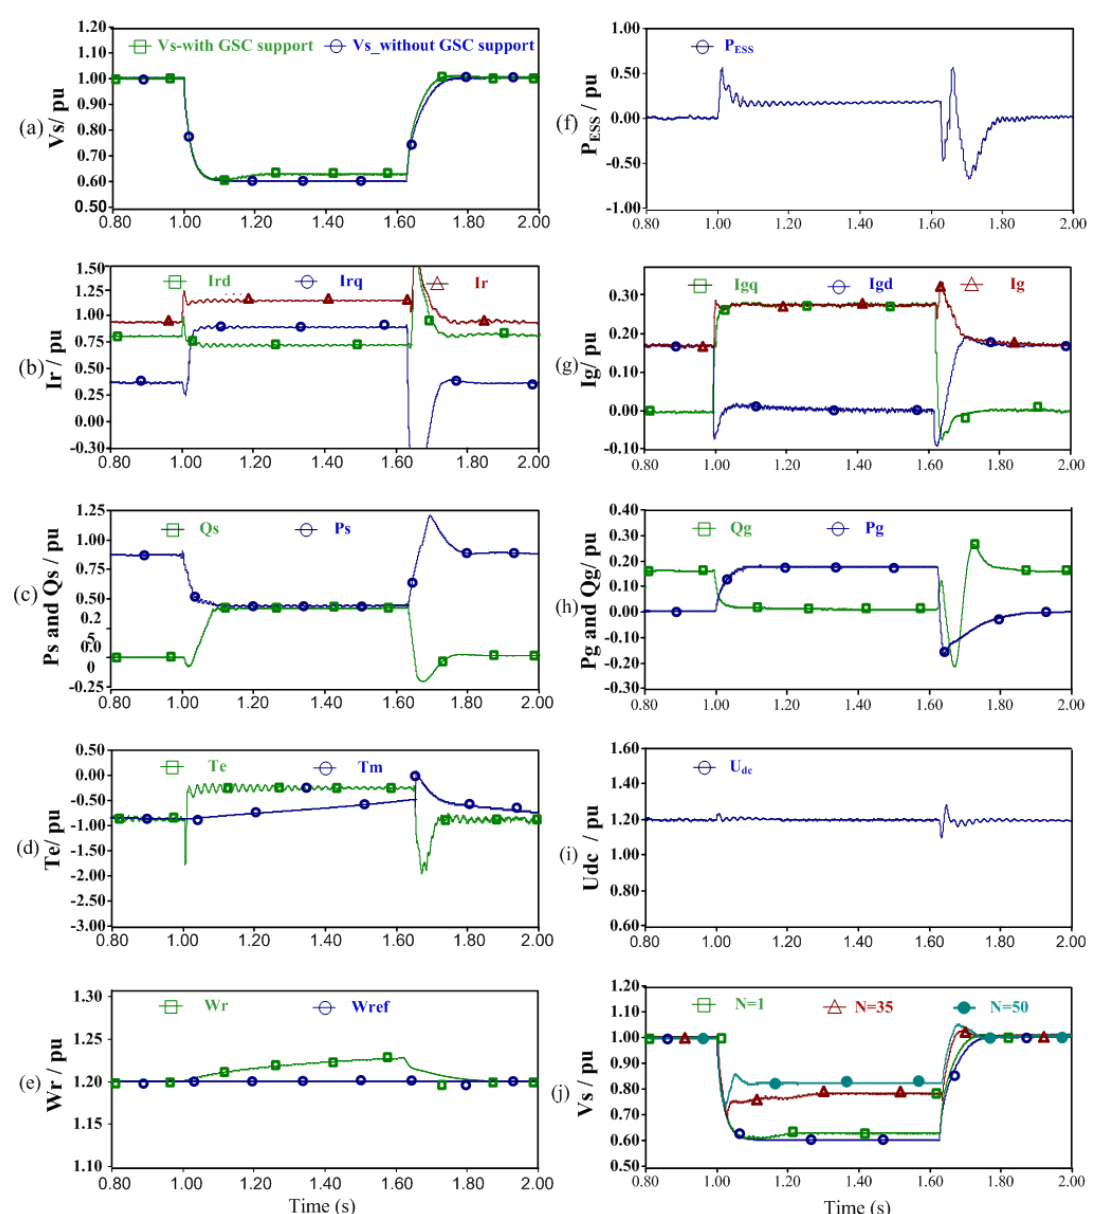
Figure 15. Reactive power priority of the DFIG-ESS during voltage dips: ( a ) terminal voltage; ( b ) current of RSC; ( c ) output power of the stator; ( d ) electromagnetic and mechanical torques; ( e ) generator speed; ( f ) active power of the ESS; ( g ) current of GSC; ( h ) output power of the GSC; ( i ) DC-link voltage; and ( j ) terminal voltage with different amount of